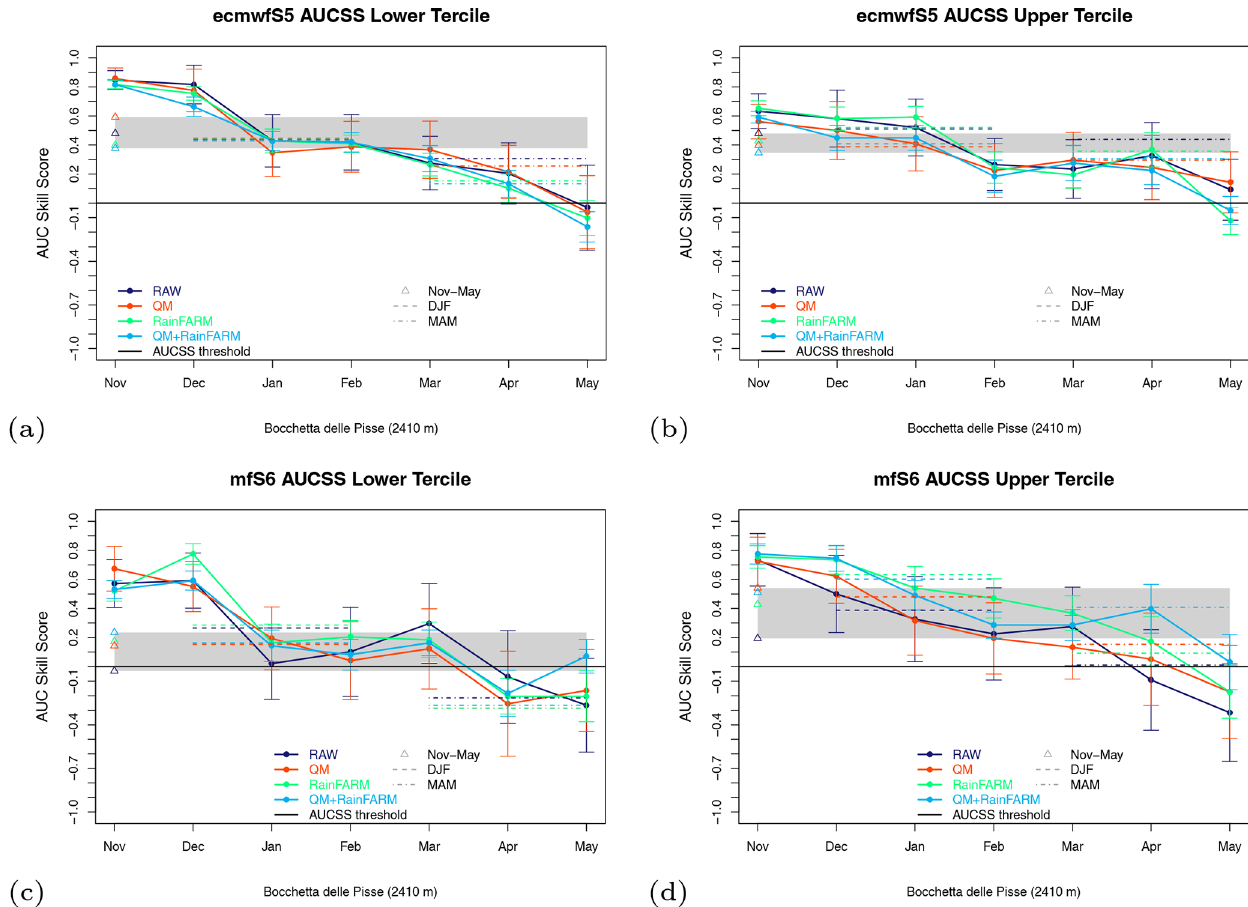
Figure 9. AUCSS for seasonal forecasts of monthly and seasonally averaged snow depth in the (a, c) lower and (b, d) upper terciles for (a, b) ECMWFS5 and (c, d) MFS6 forcing, starting date 1 November, lead times from 1 to 7 months for the site of Bocchetta delle Pisse. Coloured dots represent the AUCSSs for each month and each experiment, dashed (dotted-dashed) horizontal lines represent DJF (MAM) AUCSS values, the grey-filled rectangle and the four coloured triangles all refer to the seasonal (November–May) snow depth forecasts, indicating the AUCSS spread (min–max) and the AUCSS values for the four experiments,